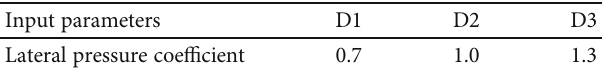
Table 5: Input parameters of scenario D.